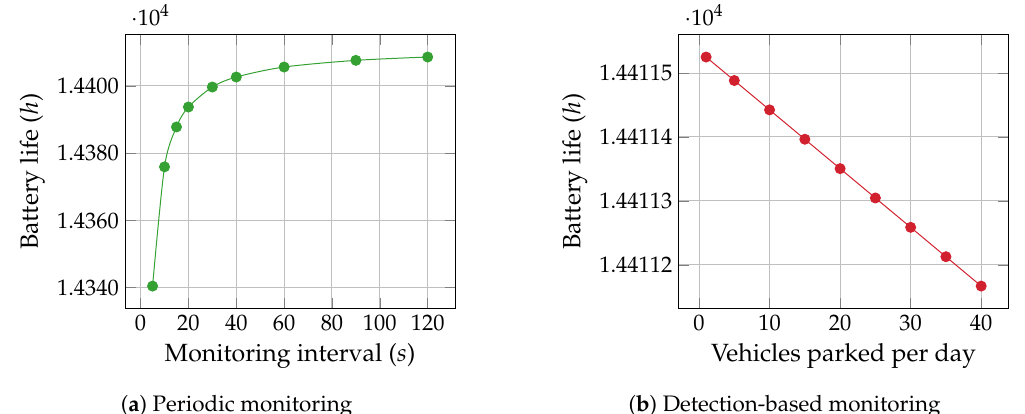
Figure 9. Sensor node’s battery (10,000mAh) life during Periodic and Detection-based